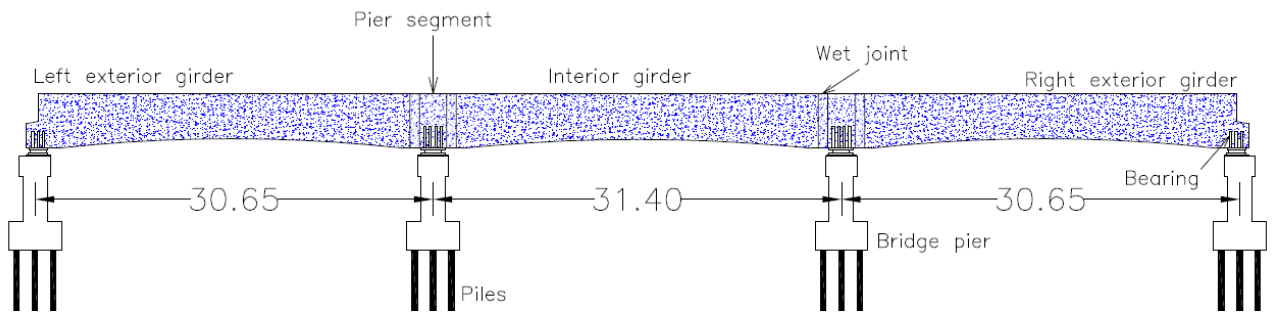
Figure 1. Typical details of test specimen (SP-1).